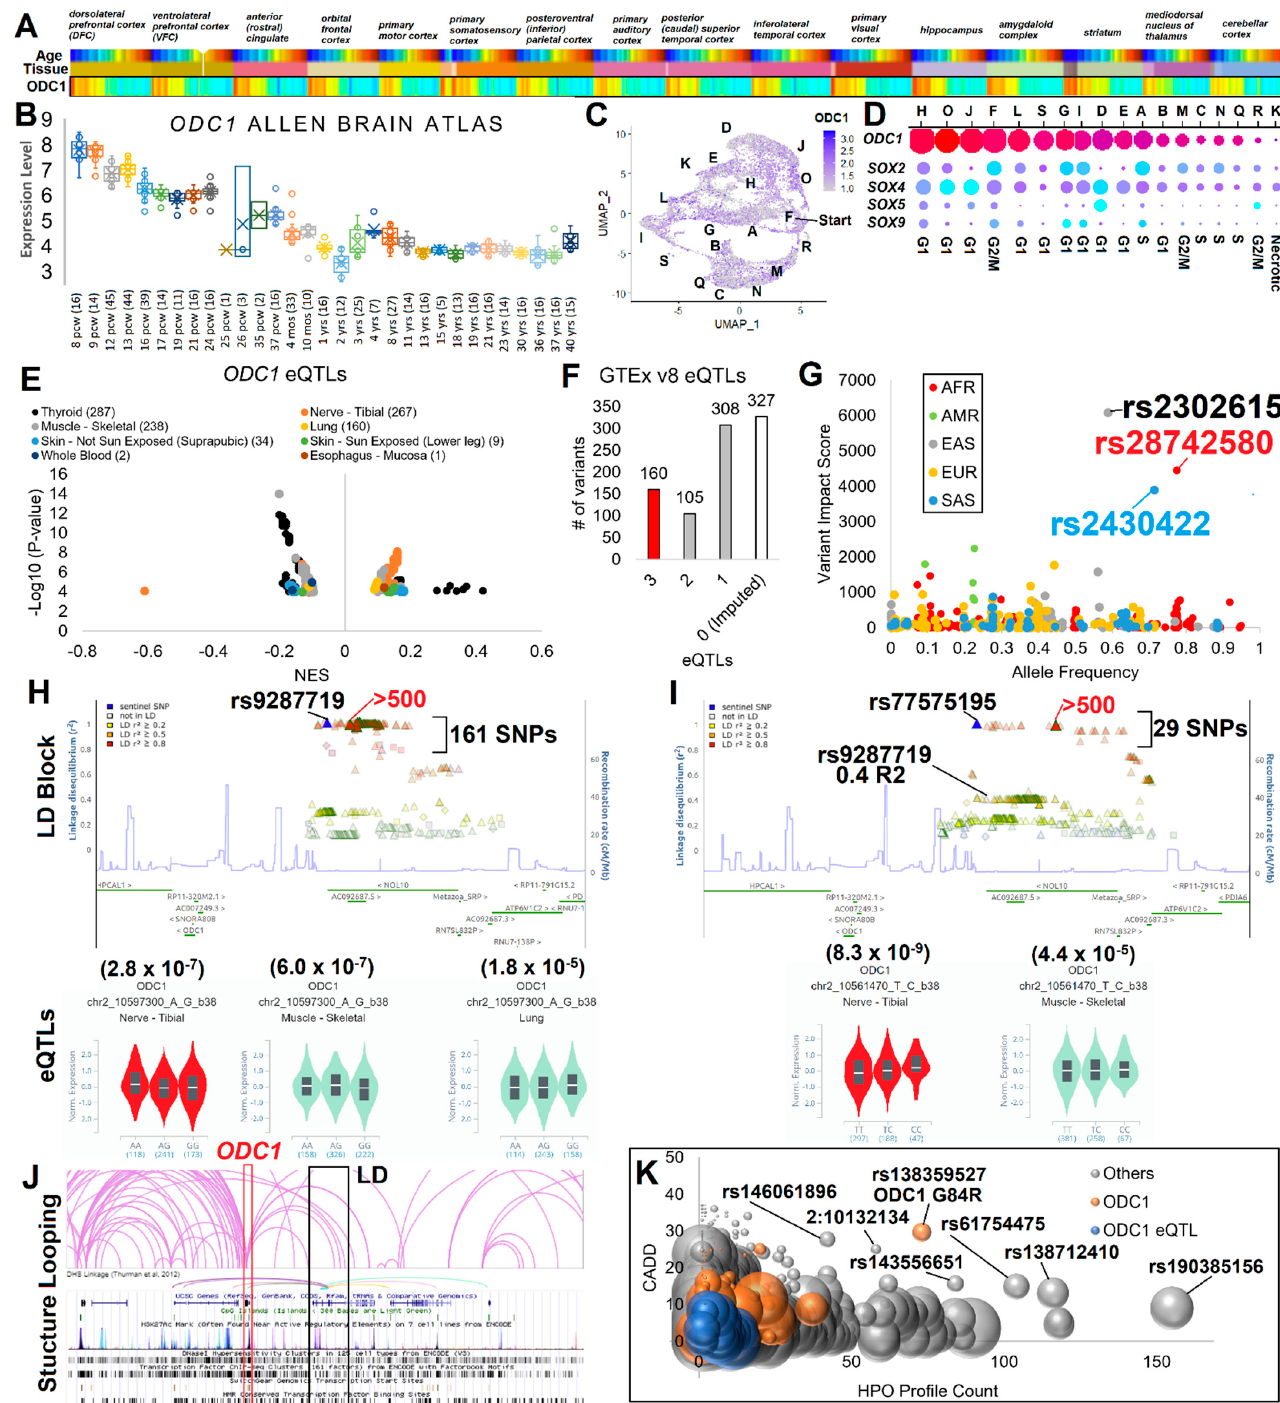
Figure 2. ODC1 gene regulation and functional genomics. 10 − 7 ( A ) Allen Brain Atlas Developmental Transcriptome data for ODC1 expression. On top are labeled tissue types. First color heatmap is for age, with youngest in blue and oldest samples in red. ODC1 levels are on a color scale of red (high) to blue (low). ( B ) Clustering of ODC1 expression from panel A for each age group shown as a box and whisker plot. The number of tissues and samples are marked in brackets for each age group. ( C ) UMAP for cerebral organoid single cell RNA-Seq showing ODC1 expression. Cell cluster annotations are labeled. ( D ) Expression of ODC1 in each cluster is shown as a dot plot. The size of each spot represents the percent of cells in the cluster expressing ODC1 and the color corresponds to the expression levels. Shown below are dot plots for four SOX genes. ( E ) Volcano plot of ODC1 linked eQTLs with tissue types colored and legend labeling number of eQTLs observed in each. ( F ) The number of times eQTLs (or 0.8R2 imputed) occurred across different tissues. ( G ) SNPs shown